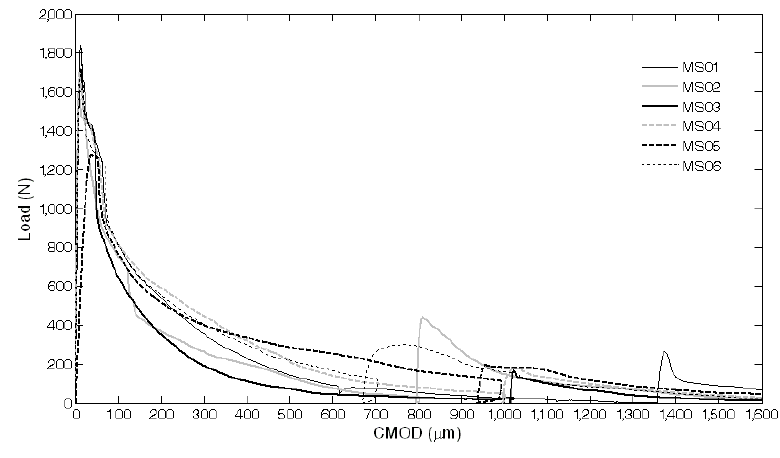
Figure 13. Load vs . CMOD curves for self-healing specimens with maccheroni (MS series) resulting from pre-loading and re-loading